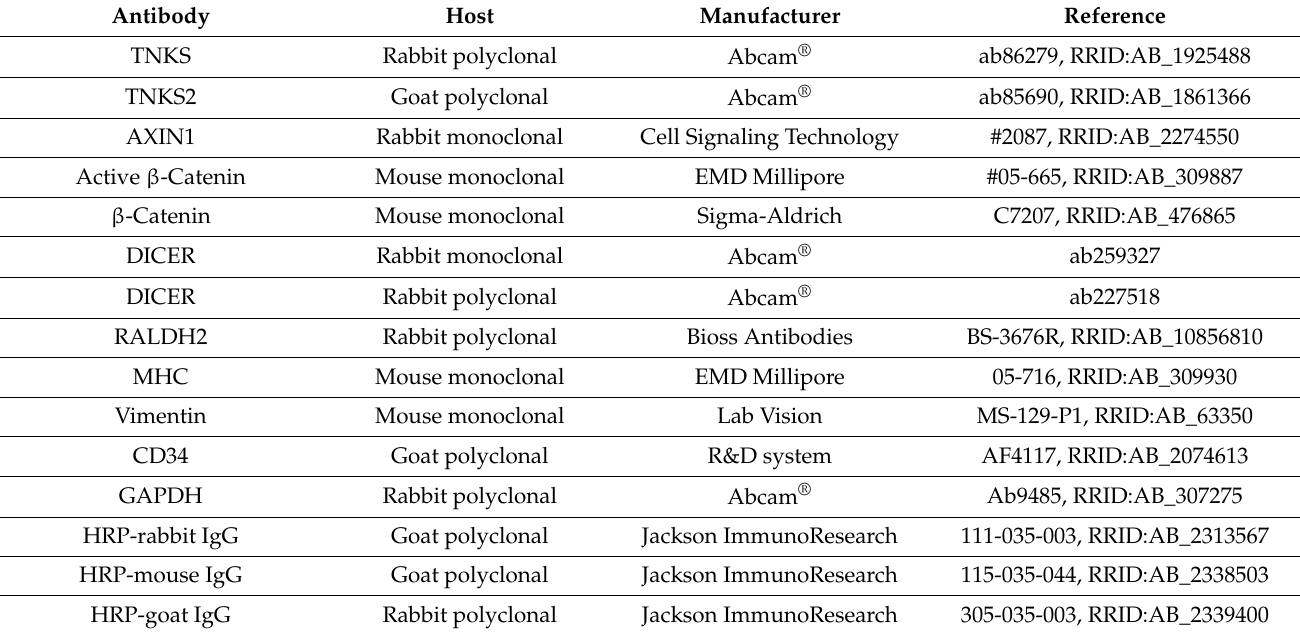
Table 2. List of antibodies used in the